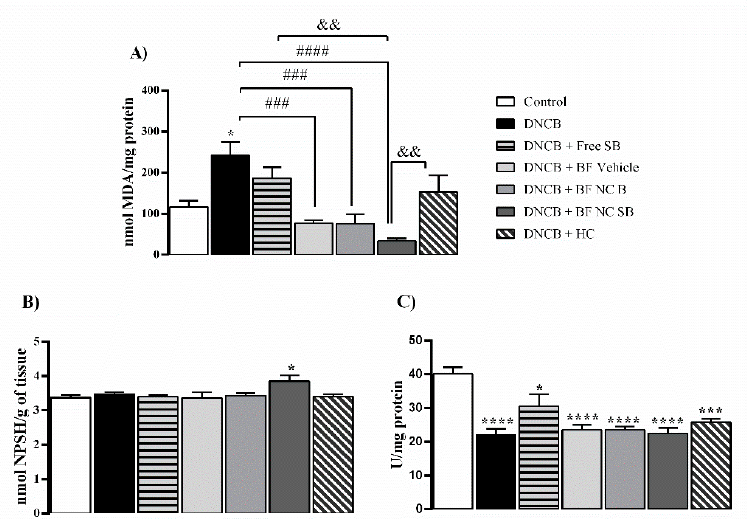
Figure 9. Effect of the different treatments on the levels of TBARS ( A ) and of NPSH ( B ) as well as on the CAT activity ( C ) in the dorsal skin of mice exposed to DNCB. Each column represents the mean ± SEM of 7 mice per group. (****) p < 0.0001, (***) p < 0.001 and (*) p < 0.05 compared with the control group, (####) p < 0.001 and (###) p < 0.01 compared with the DNCB group, (&&) p < 0.01 compared with the BF NC SB group (One-way ANOVA followed by the Tukey’s test).